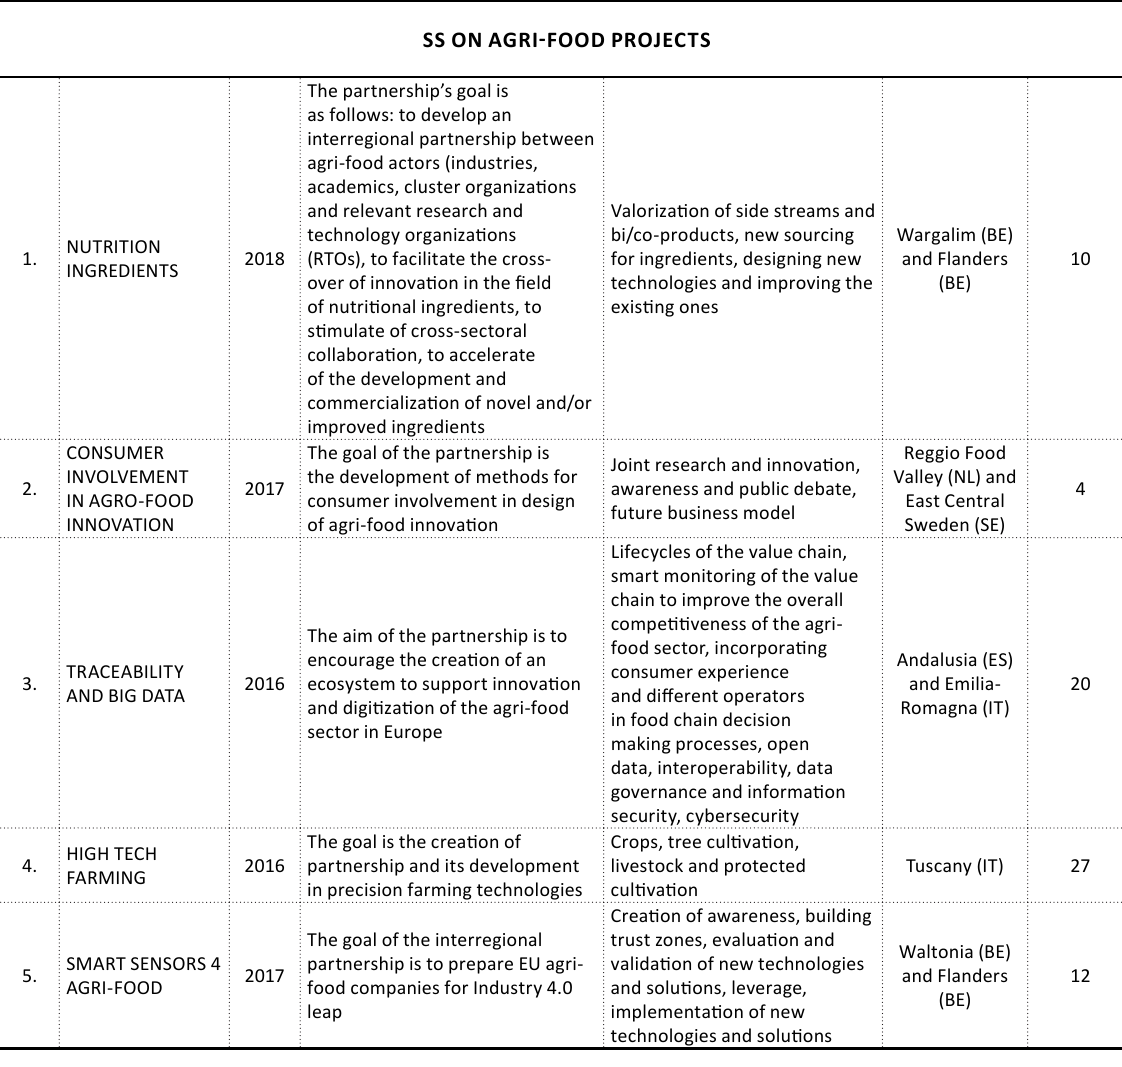
Table A1. Examples of SS projects in the EU countries